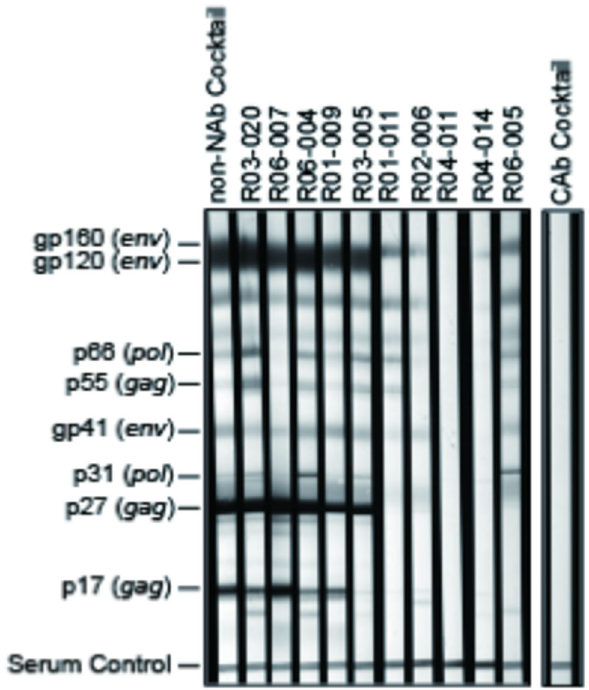
Figure 2. Binding properties of IgGs to SIV antigens. The non-NAb cocktail, ten non-NAb IgG lots derived from ten macaques, and CAb were subjected to immunoblotting (ZeptoMetrix). A representative result from two experiments is shown.